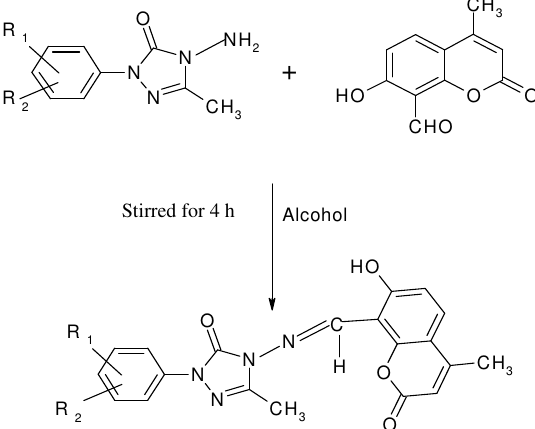
Figure 3 . Systematic scheme for preparation of Schiff bases.